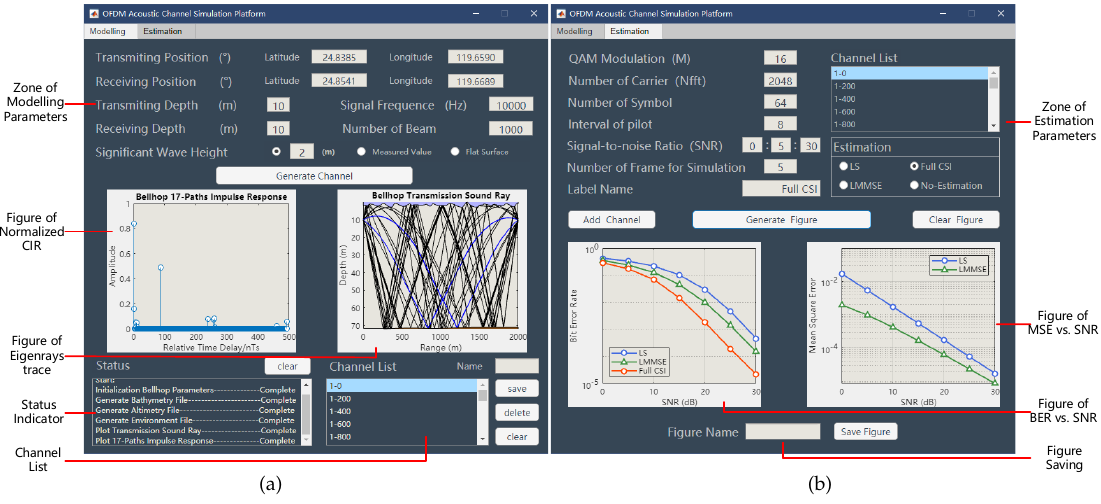
Figure 2. The user interface of simulation platform. ( a ) underwater acoustic (UWA) channel modelling. ( b ) OFDM channel